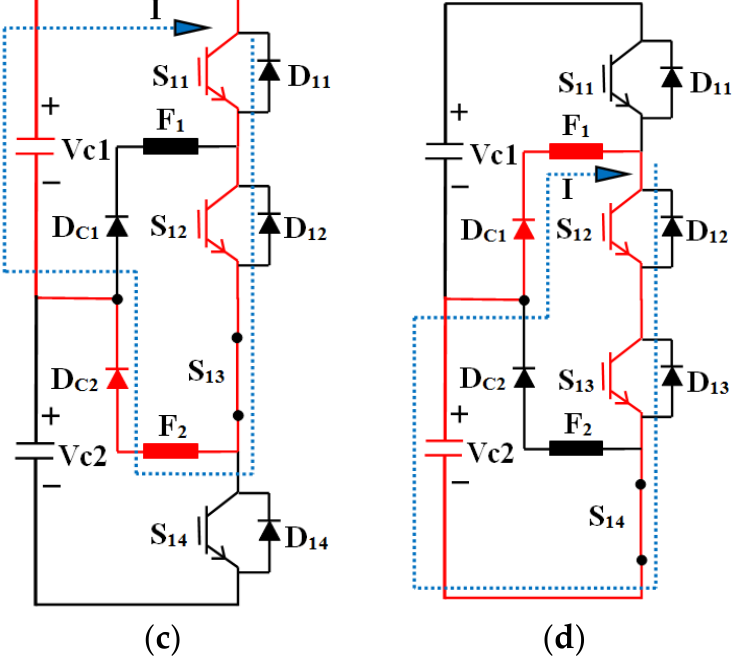
Figure 2. Short-circuit current loop in the case of a short-circuit fault event in: ( a ) S11; ( b ) S12; ( c ) S13; ( d ) S14.